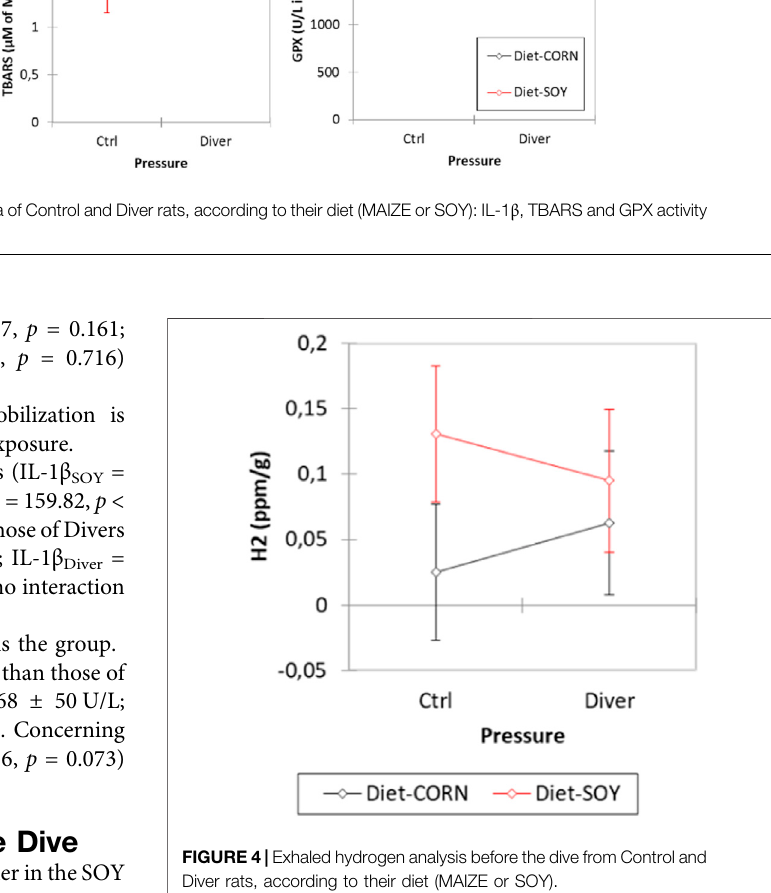
Frontiers in Physiology |